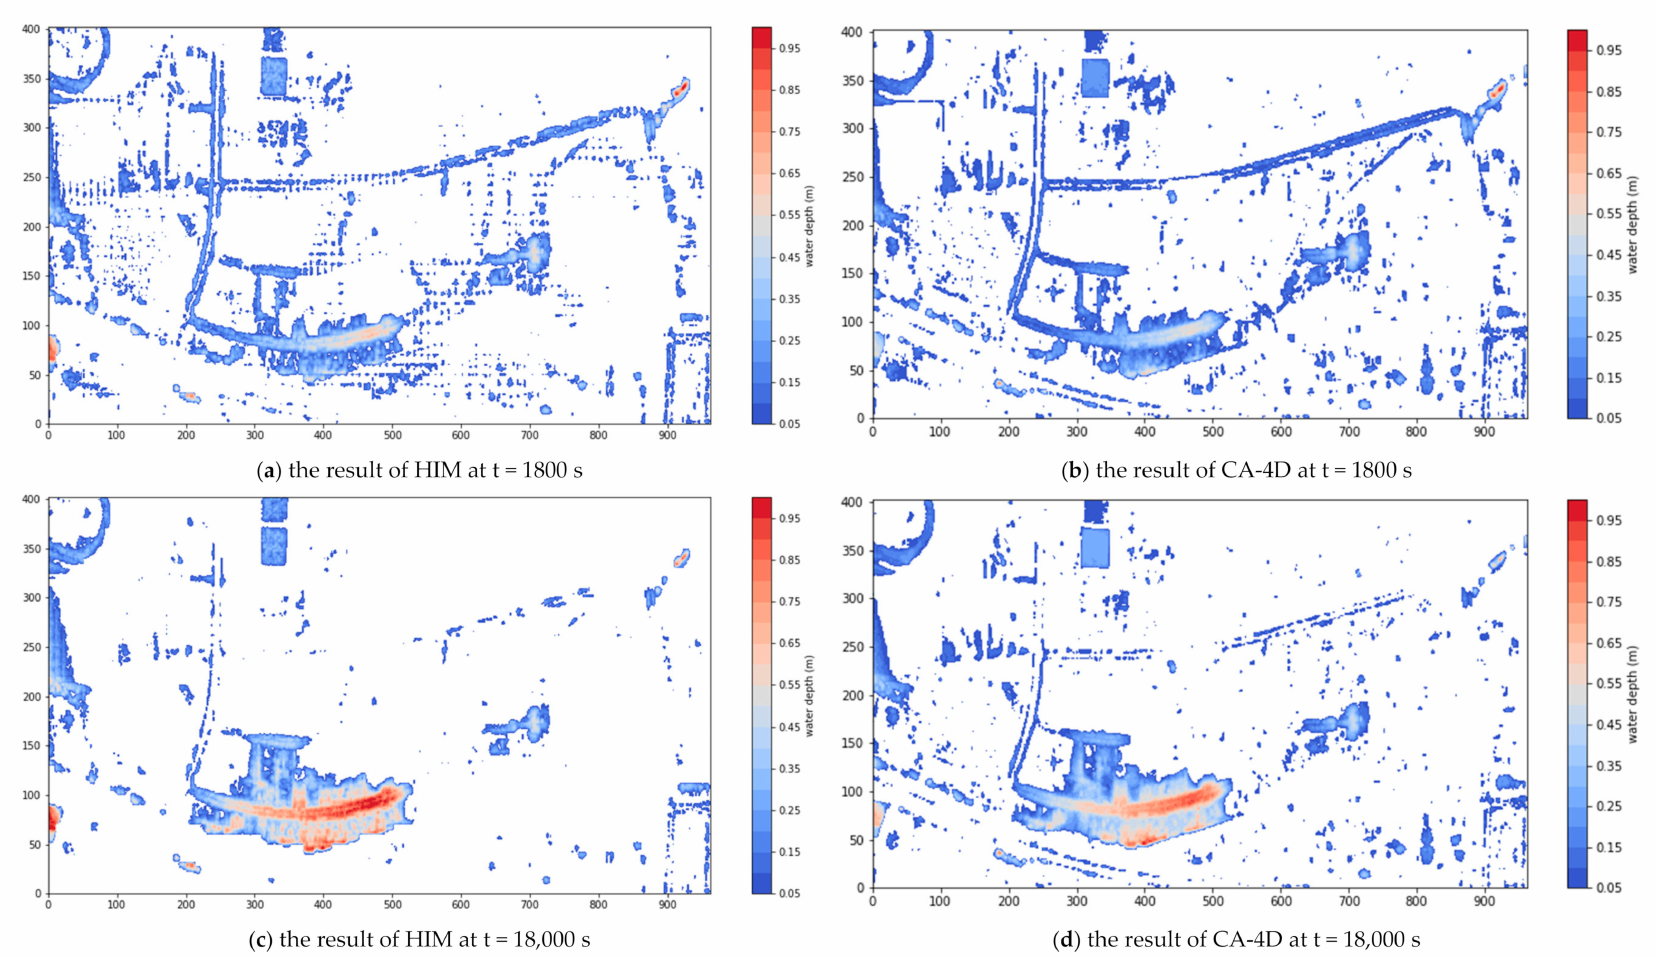
Figure 15. Flood extents produced by the HIM (left column) and CA-4D (right column) at t = 1800 s (first row) and t = 18,000 s (second row); ( a ) the result of HIM at t = 1800 s; ( b ) the result of CA-4D at t = 1800 s; ( c ) the result of HIM at t = 18,000 s; ( d ) the result of CA-4D at t = 18,000